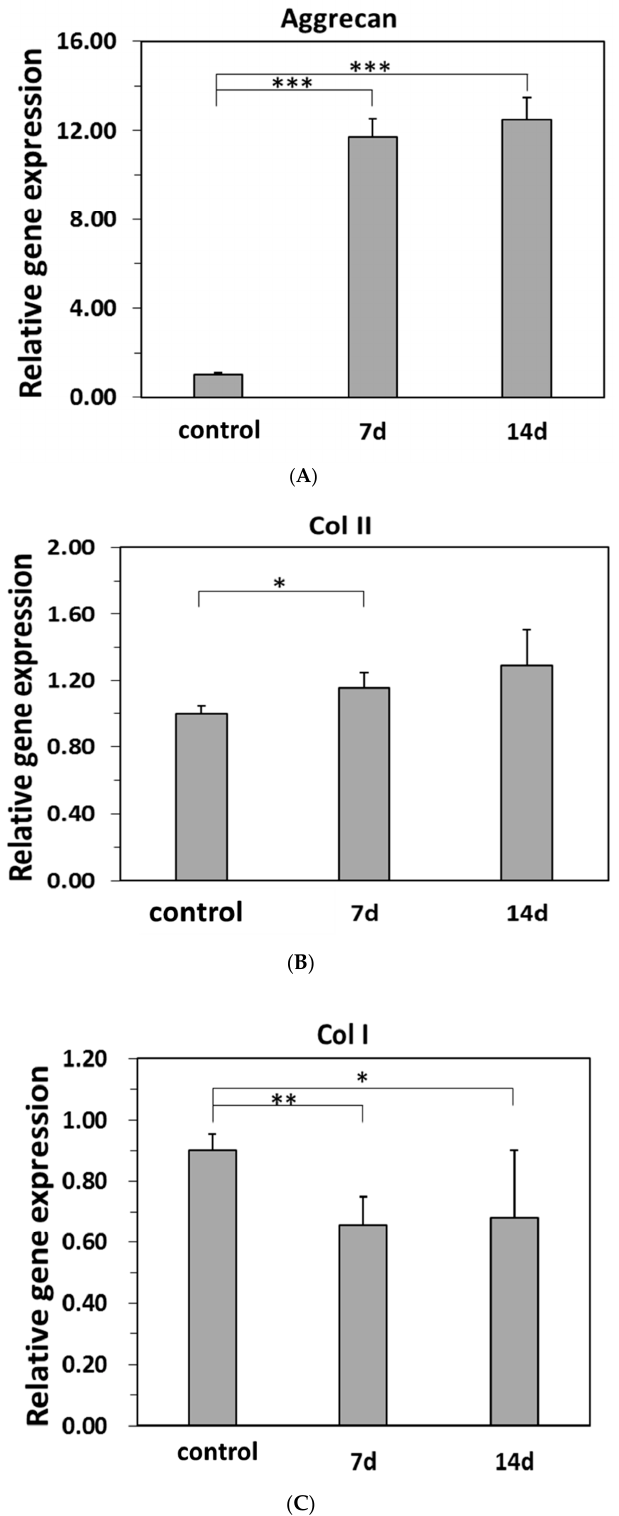
Figure 7. Real-time PCR analysis for the relative quantities of NP-specific gene expressions of inducing differentiation of hBMSC to NP cells on the model hydrogels for 7 d and 14 d. Gene expressions of AGN ( A ), COL II ( B ) and COL I ( C ) for the control group (e.g., ctrl) were the data for 7 d incubated at cultural wells. (* p < 0.05, ** p < 0.01, *** p < 0.001; data presented are mean ±SD, n = 3).